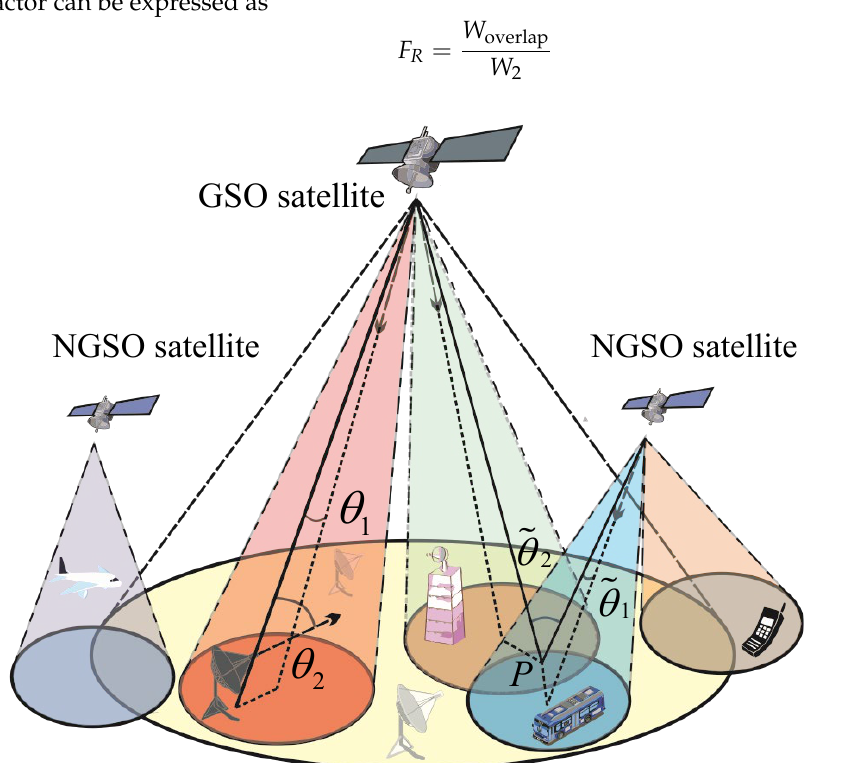
Figure 1. An illustration of the downlink interference